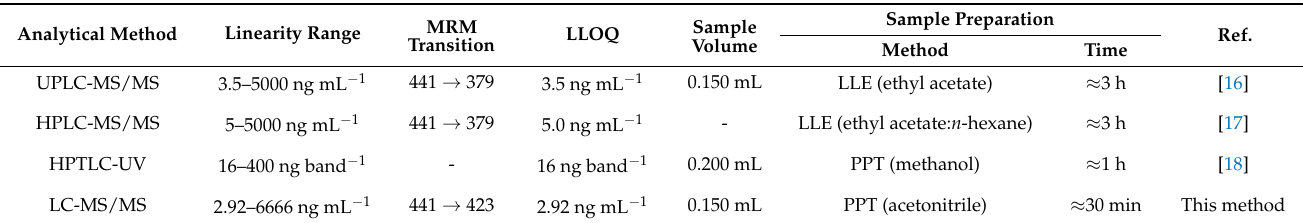
Table 5. Comparison of the proposed method with previous reported methods for the determination of DFX in plasma